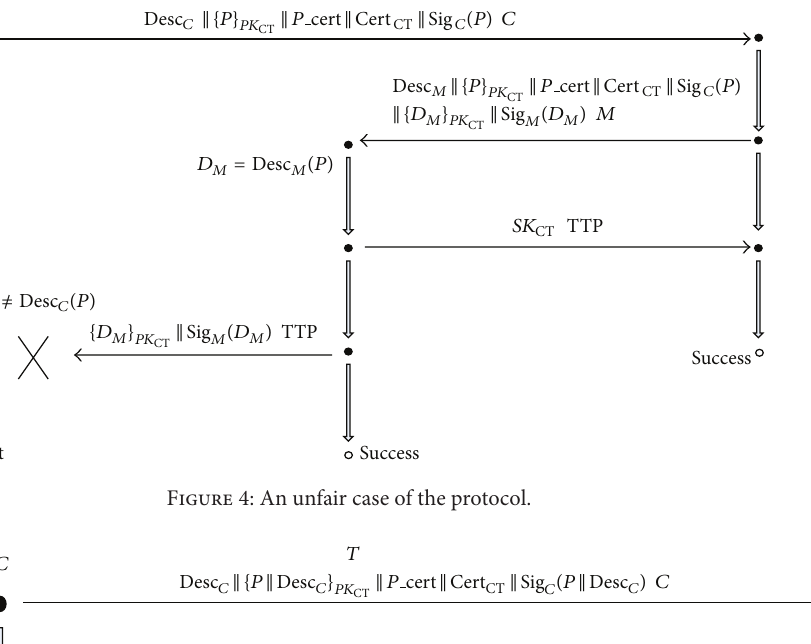
Figure 4: An unfair case of the protocol.